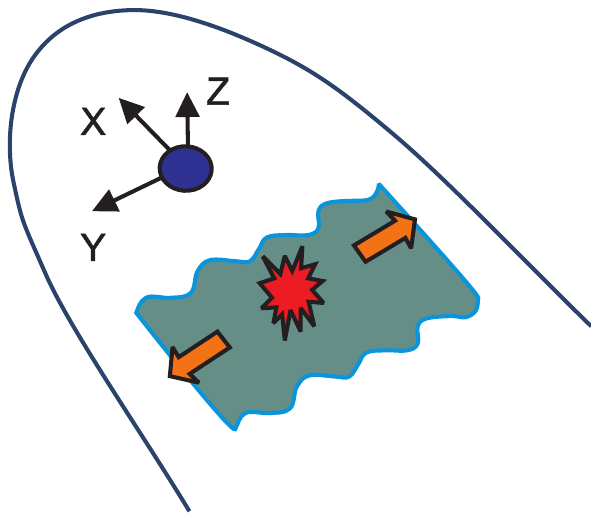
Fig. 9. Position of the source for the flapping